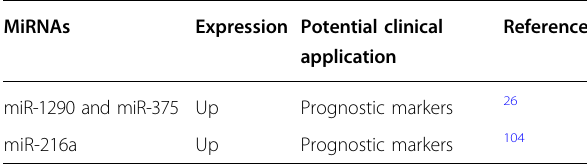
Table 2 Clinical application of miRNA in prostate cancer. MiRNAs